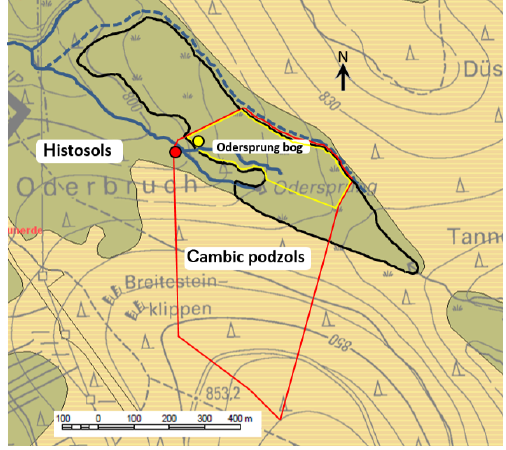
Figure 1. Location of the study area in the Harz Mountains, Ger- many. Red and yellow lines indicate each catchment boundary, cir- cles represent the discharge monitoring spots (yellow – bog catch- ment; red – forest catchment with peaty riparian zone). Green ar- eas indicate peaty soils, beige-colored areas outline mineral cambic podzol soils. The bog area is confined by the bold black line. Map source: NIBIS mapserver, Lower Saxony authority for mining, en- ergy and geology